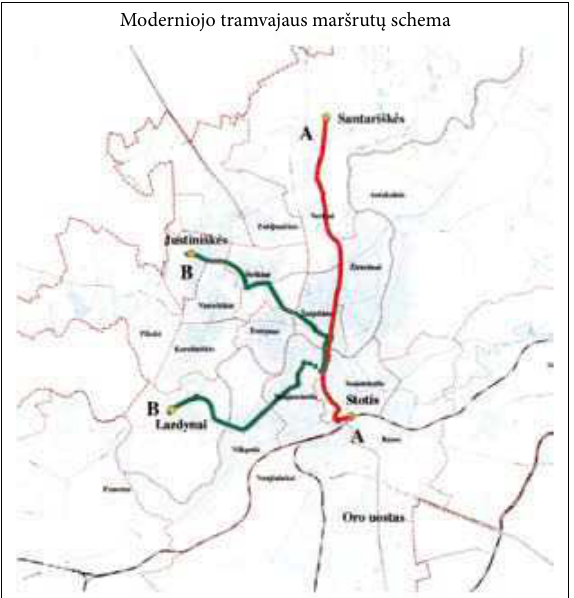
Fig. 2. First two (red and blue) fast-tram lines from 1980– 1983 Vilnius General Plan and complements of such first lines in 1996 and 1998 Master Plans